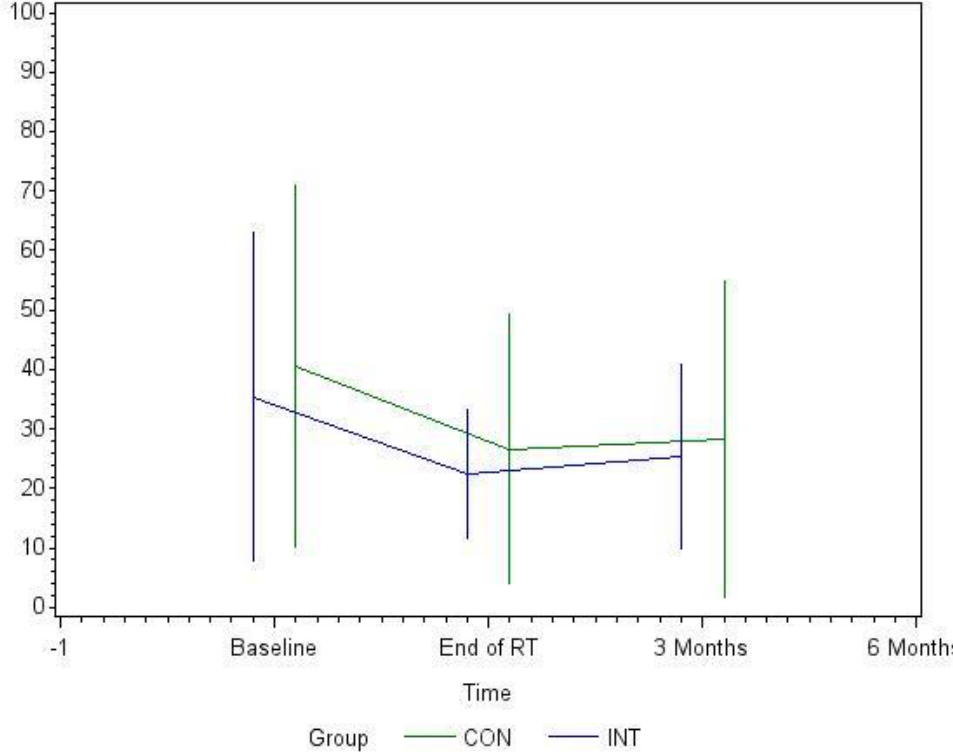
Figure 3. Graphical representation of pain levels using the Visual Analogue Scale (VAS) during the observation period in both groups.